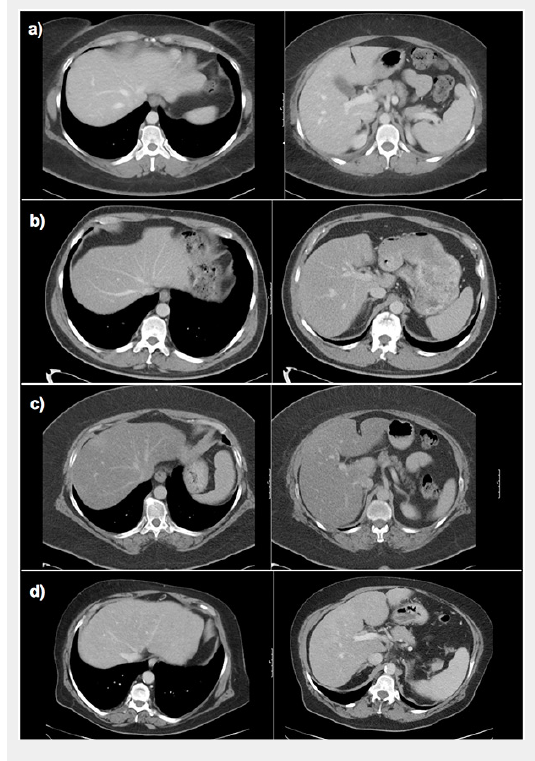
Fibrosis assessment with the ld/crl ratio in different patients. a) Normal liver: wide hepatic veins, caudate lobe smaller than right liver lobe on visual impression. Calculation of the ld/crl-r not mandatory (ld: 2.5 cm, crl-r: 0.75, ld/crl-r: 33.2). b) Hepatitis C fibrosis grade 1: small hepatic veins, caudate lobe width similar to right hepatic lobe width on visual impression, calculation of the ld/crl-r recommended (ld: 1.5 cm, crl-r: 0.78, ld/crl- r: 19.2).